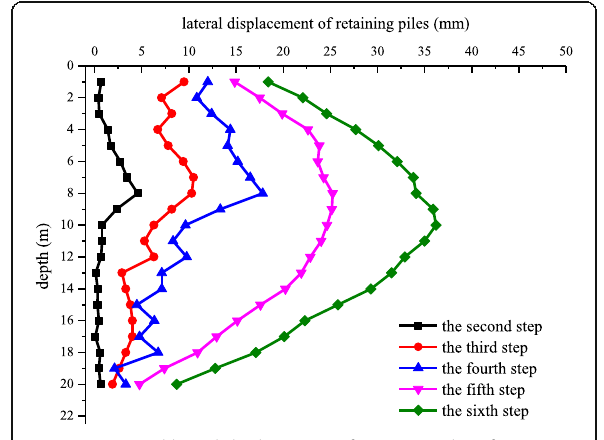
Fig. 7 Monitored lateral displacement of retaining piles of